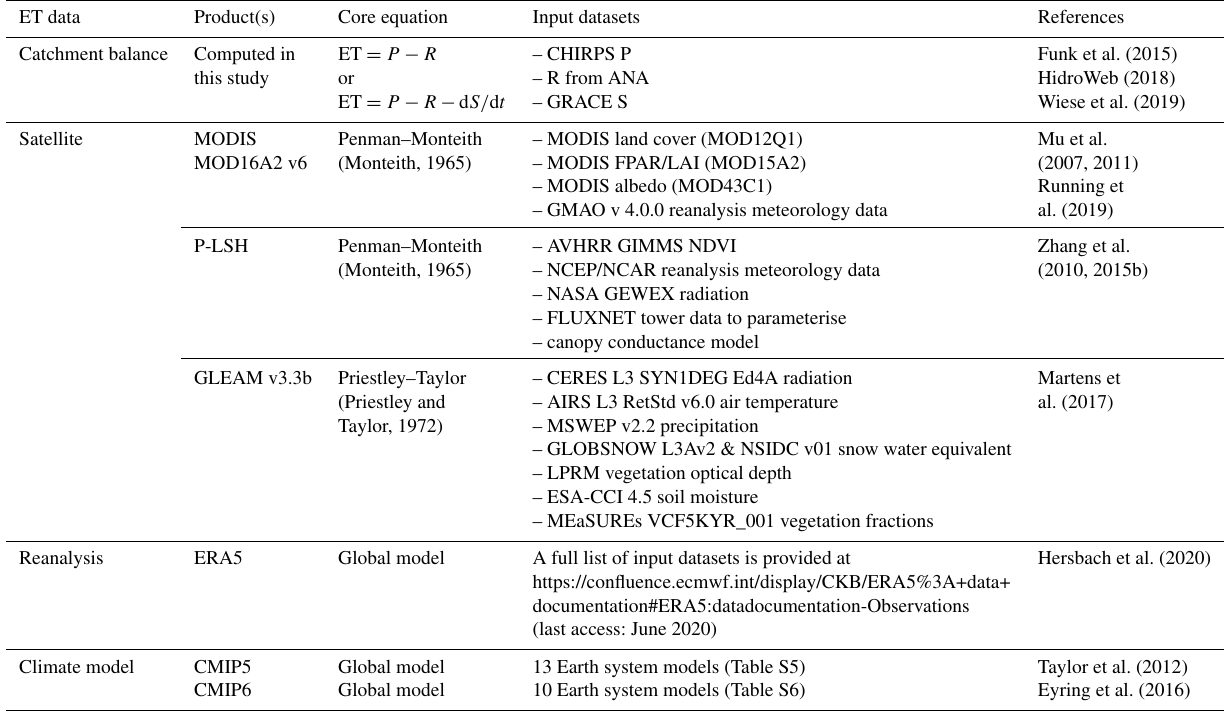
Table 1. Details of the evapotranspiration (ET) datasets analysed in this study. ET